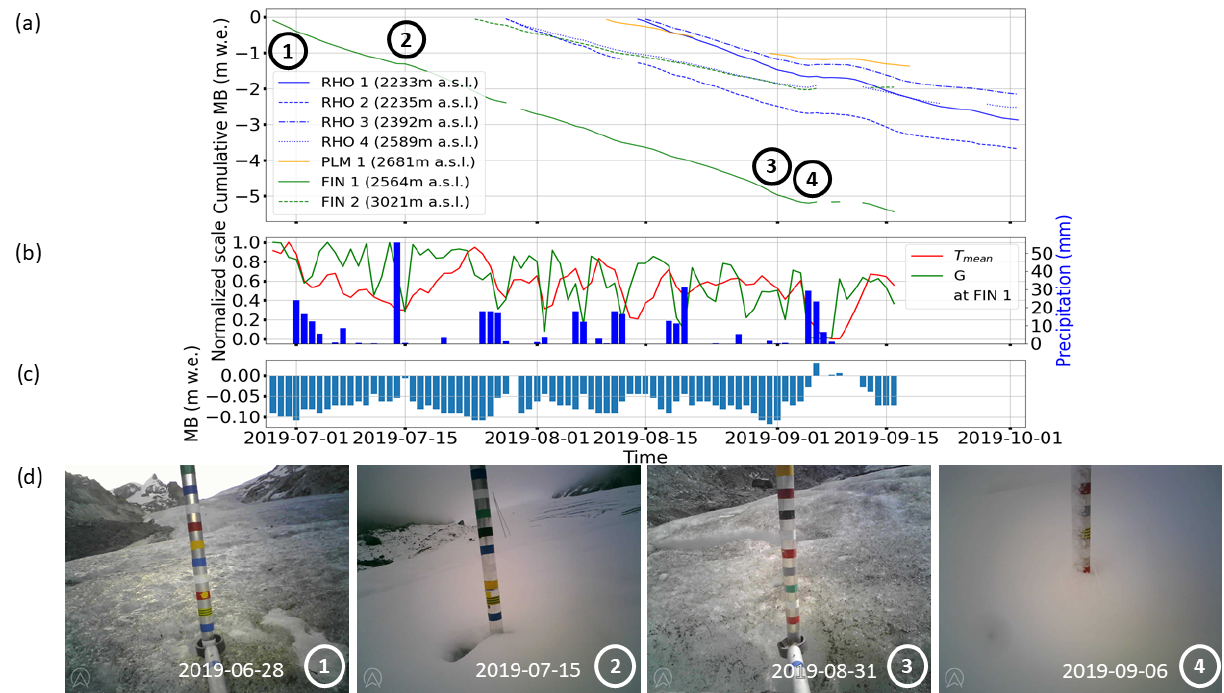
Figure 7. (a) Cumulative mass balance at individual camera stations during summer 2019. The circled numbers refer to the pictures shown in panel (d) . (b) Normalized mean temperature T mean and shortwave radiation G (left axis) normalized to their respective ranges, as well as precipitation (right axis) for station FIN 1. (c) Daily mass balance rate observed at FIN 1. (d) Sample images as captured by the camera at FIN 1: (1) camera right after setup, (2) glacier after light snowfall, (3) picture from the day with the highest melt (0.12mw . e . ), and (4) snowfall event hampering the stake